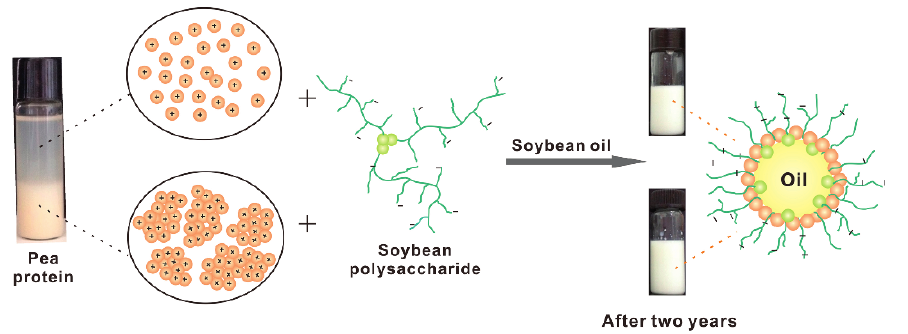
Figure 11. TEM images of the four complex emulsions prepared with 10 v% oil phase. The scale bars are 500